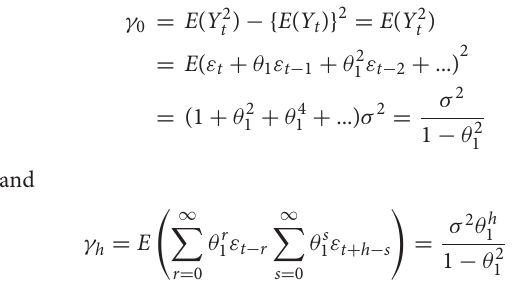
FIGURE 5 | The Gamma distribution is the distribution of a random variable X for which E ( X ) = κθ = α log ( α ) − log ( σ ) is fixed ( ψ is the digamma function). The presented figure represents different gamma curves for different values of the parameters α and σ .